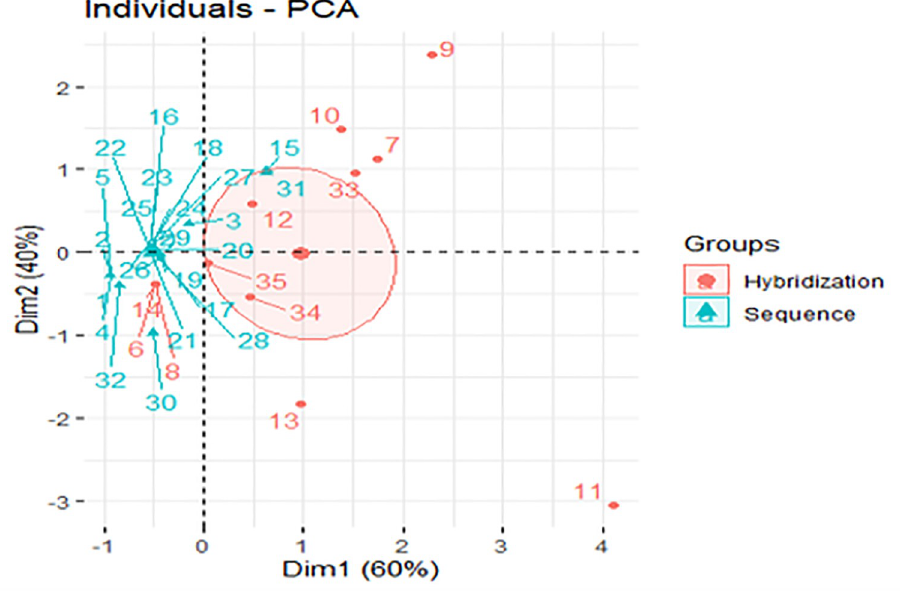
Fig 4. PCA of individual unculturable bacteria in periapical abscesses categorized by sequence techniques supplementary variable.